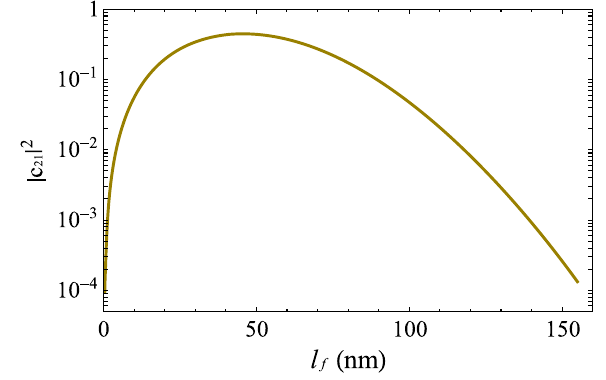
FIG. 2. Dependence of j c 21 j 2 on l Gaussian particle distribution in hydrogen for d n 0 ¼ 6 × 10 19 cm − 3 , and γ ≫ I= ω